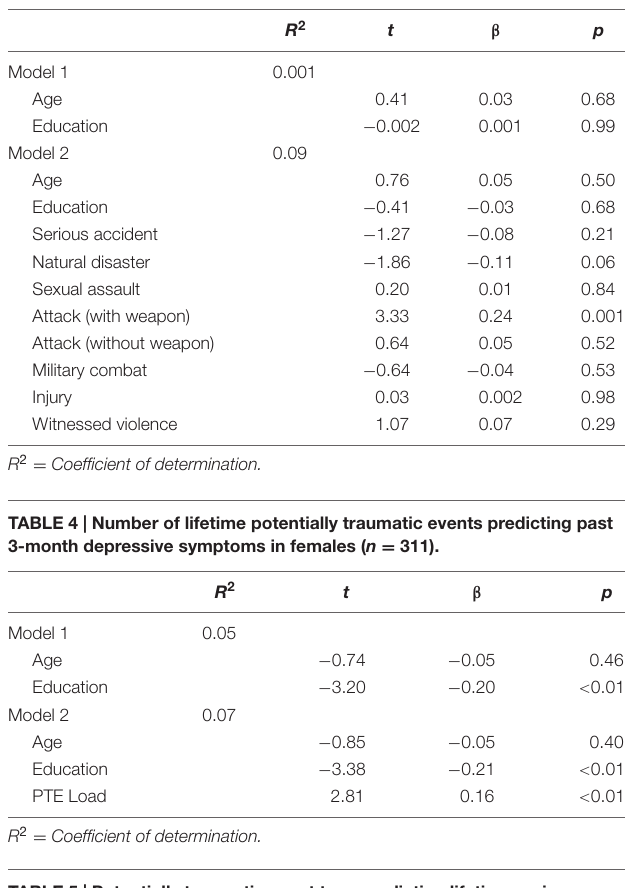
TABLE 5 | Potentially traumatic event type predicting lifetime major depressive episode symptoms in females ( n =